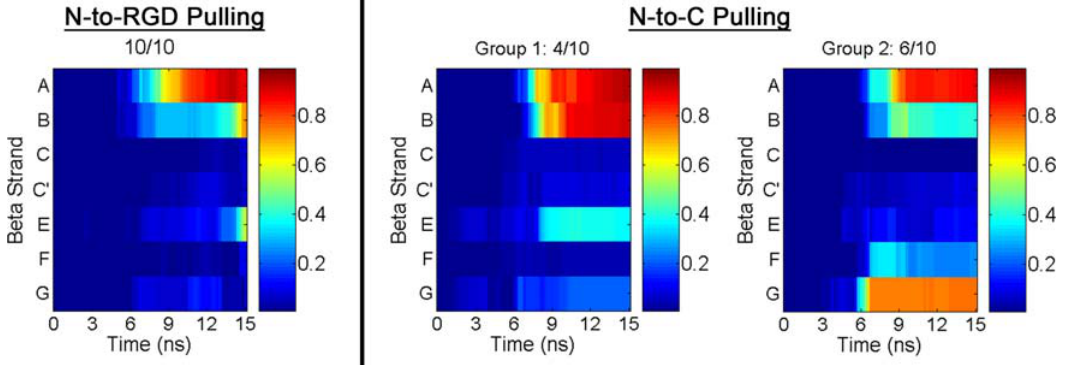
Figure 4. Solvent Accessibility Factor of Each b -strand During the Early Stages of Unfolding. The color scale (right), ranging between 0 and 1, represents the degree of solvent exposure of the b -strand (labeled A through G , left) for time # 15 ns. With this scaling, b -strands in the initial structures all have f =0, while fully exposed strands have f =1.